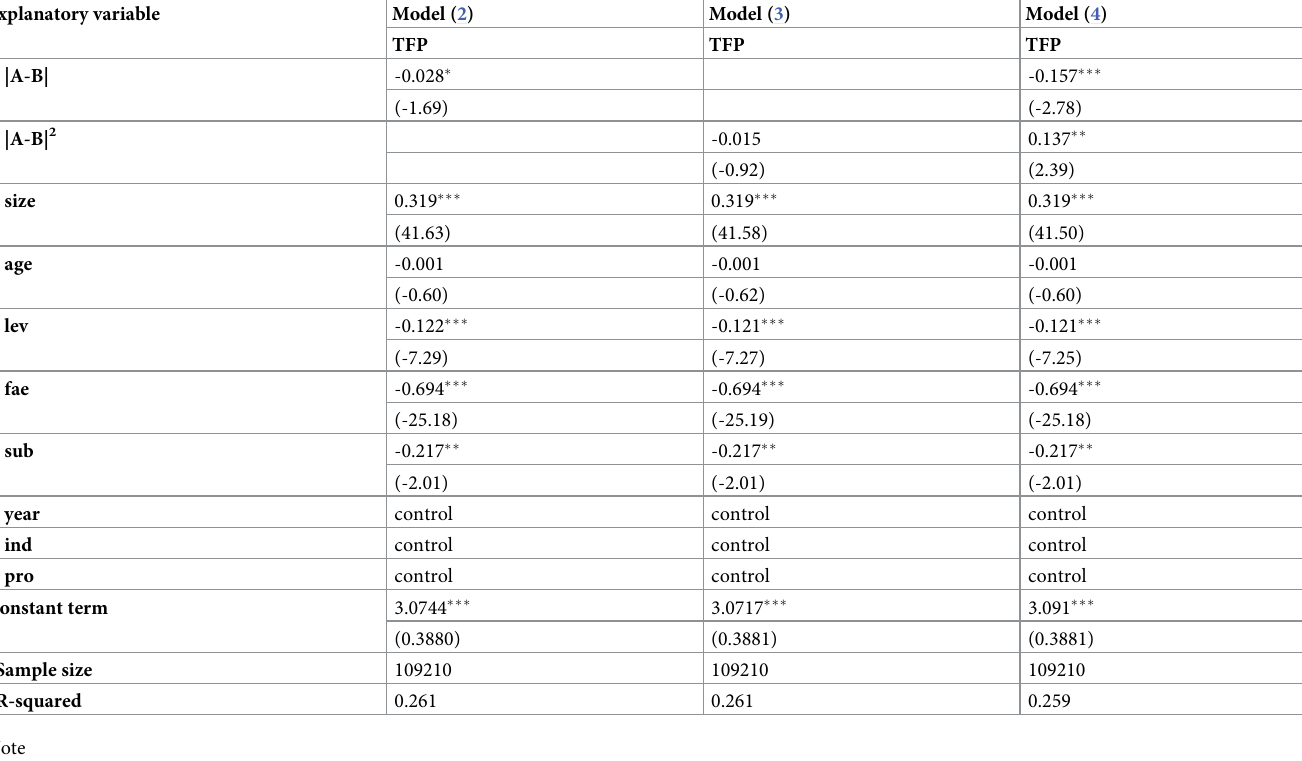
Table 4. The regression results of the effect of heterogeneous ownership balance degree on the efficiency of mixed ownership enterprises. Explanatory